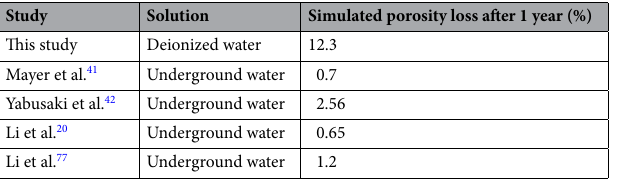
Table 2. Porosity loss simulations in different studies.